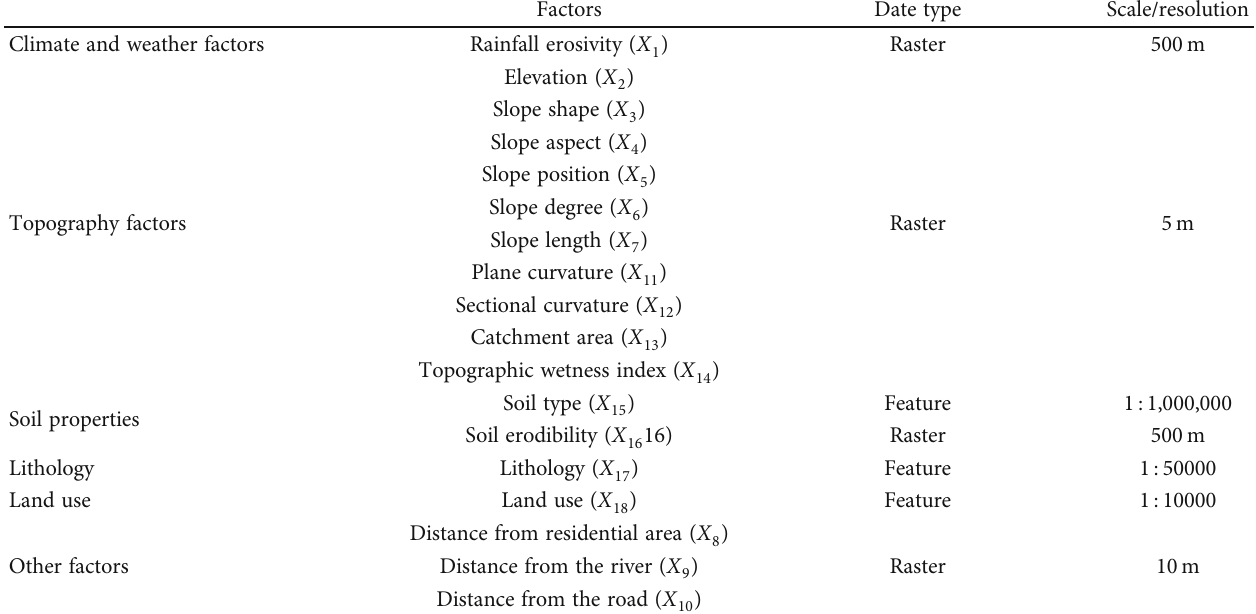
Table 1: Information on factors a ff ecting gully